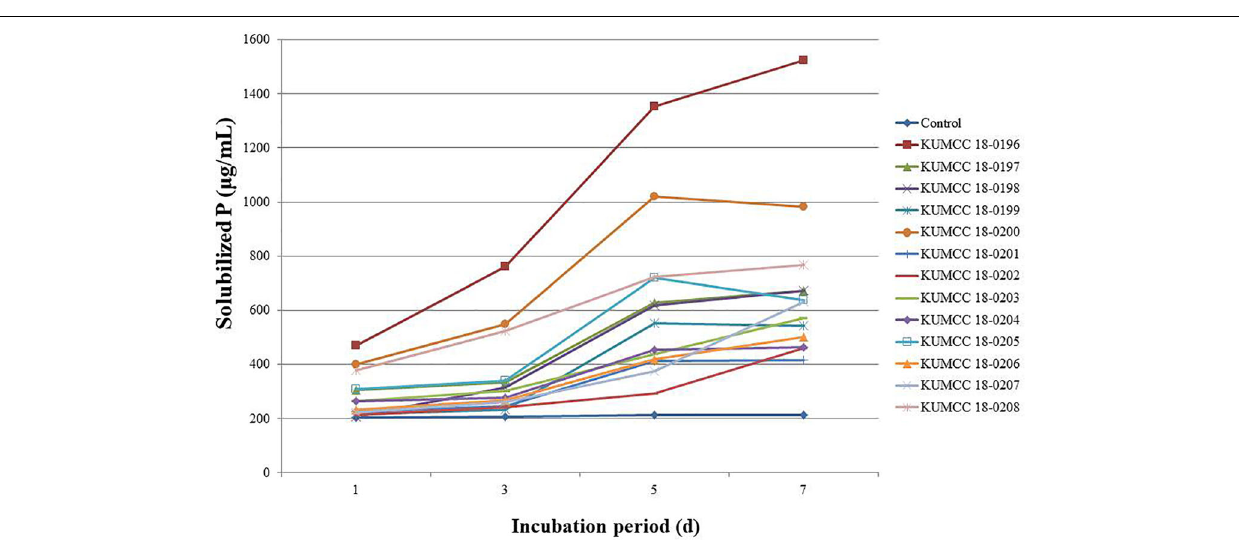
FIGURE 3 | Solubilized P concentrations of 13 fungal strains and control in PVK broth containing TCP after the 1 st , 3 rd , 5 th , and 7 th day of incubation (each value represents the mean of the S3). pH values of PVK broth containing TCP inoculated with each 13 fungal isolate and control after the 1 st , 3 rd , 5 th , and 7 th day of incubation (each value represents the mean of the three